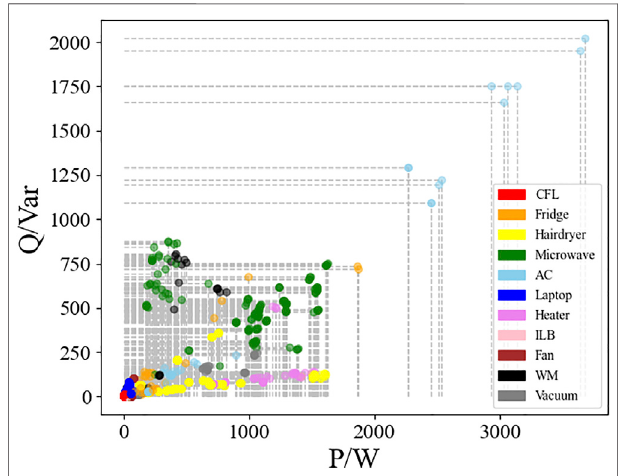
FIGURE7| Loaddistributionsintwo-dimensionalplaneoftheactiveand reactive power from